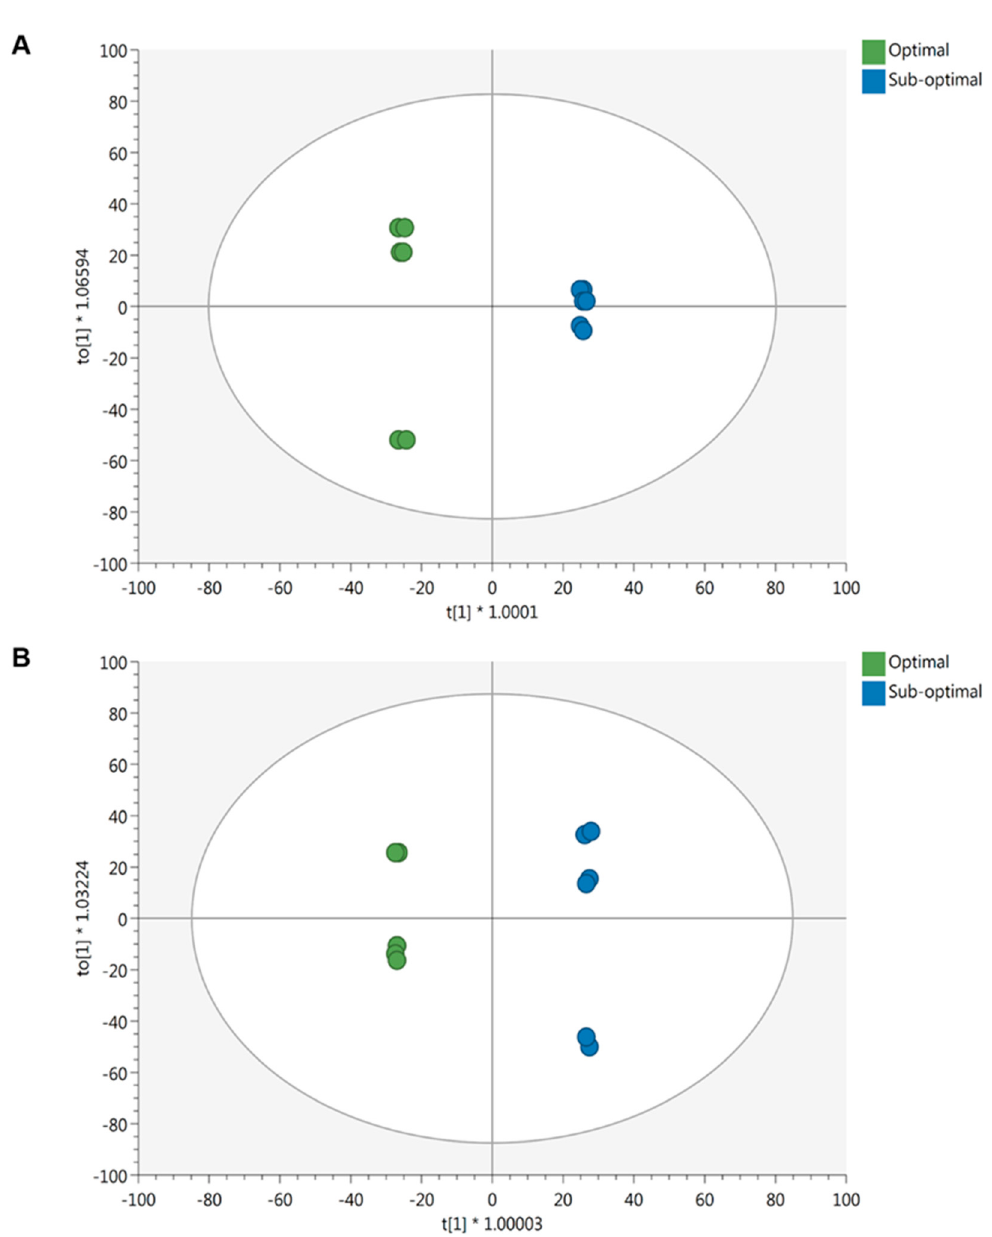
Figure 3. Score plot of OPLS-DA supervised modeling carried out on untargeted metabolomics profiles of ‘Red’ ( A ) (R 2 Y = 0.99, Q 2 Y = 0.92) and ‘Green’ ( B ) (R 2 Y = 1, Q 2 Y = 0.92) Salanova under optimal and sub-optimal light conditions.